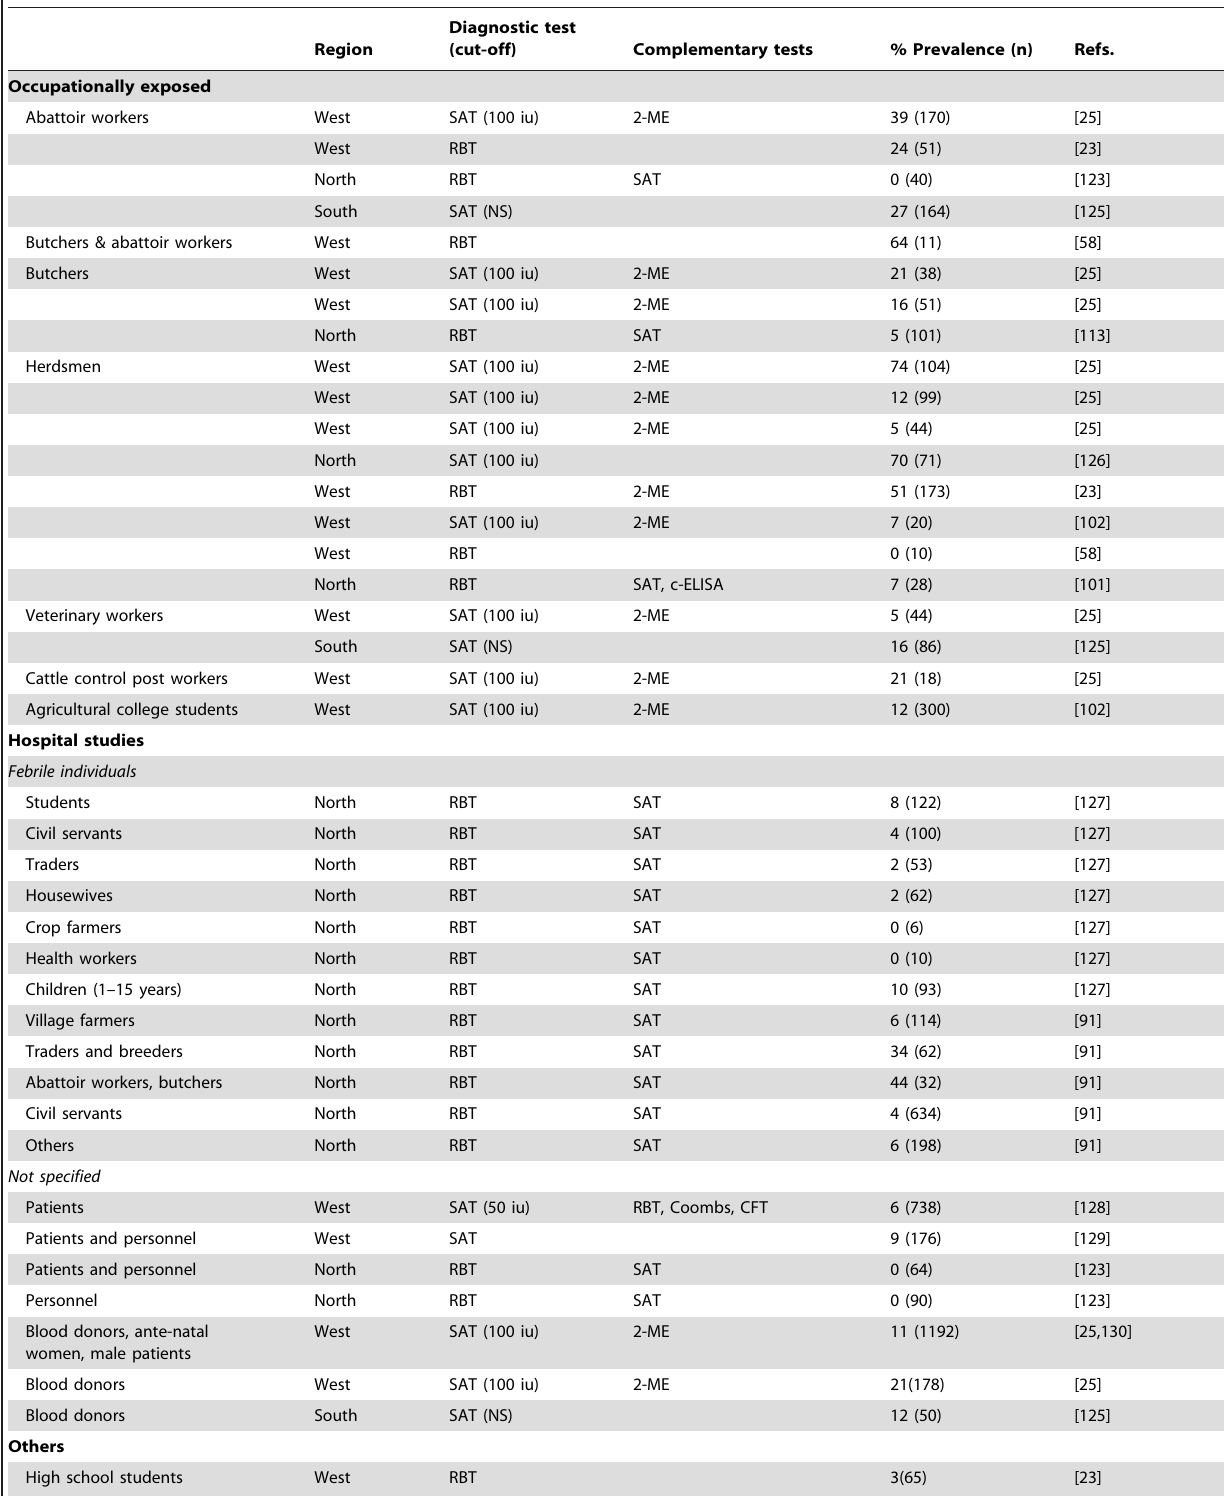
Table 5. Summary of brucellosis studies in humans in Nigeria.